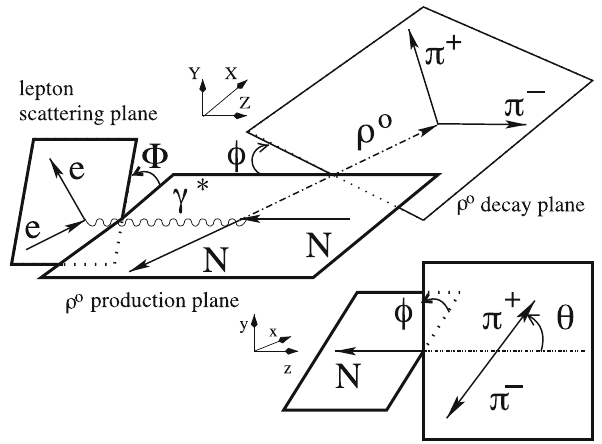
Fig. 1 Definition of angles in the process eN → e ρ 0 N → e π + π − N . Here, Φ is the angle between the ρ 0 production plane and the lepton scattering plane in the CM system of virtual photon and target nucleon. The variables θ and φ are respectively the polar and azimuthal angles of the decay π + in the ρ 0 -meson rest frame, with the z axis being anti- parallel to the outgoing nucleon momentum. The XZ and xz planes both contain the γ ∗ and ρ 0